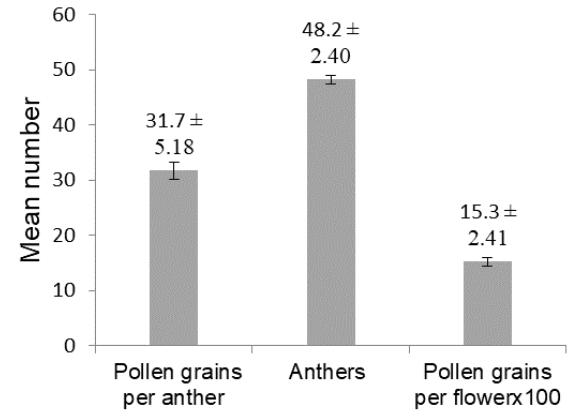
F IGURE 1. Mean number ± standard deviation of pollen grains per anther, anthers per flower and the total number of pollen grains per flower in